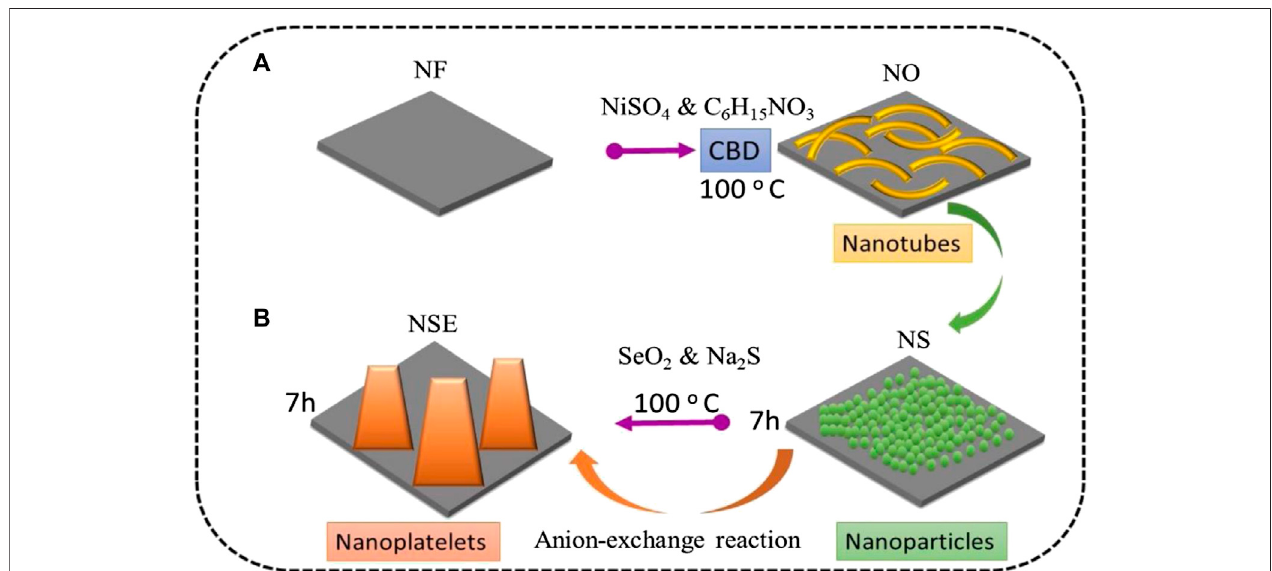
FIGURE 11 | Schematics of (A) the self-templating method and (B) anion-exchange reaction method.